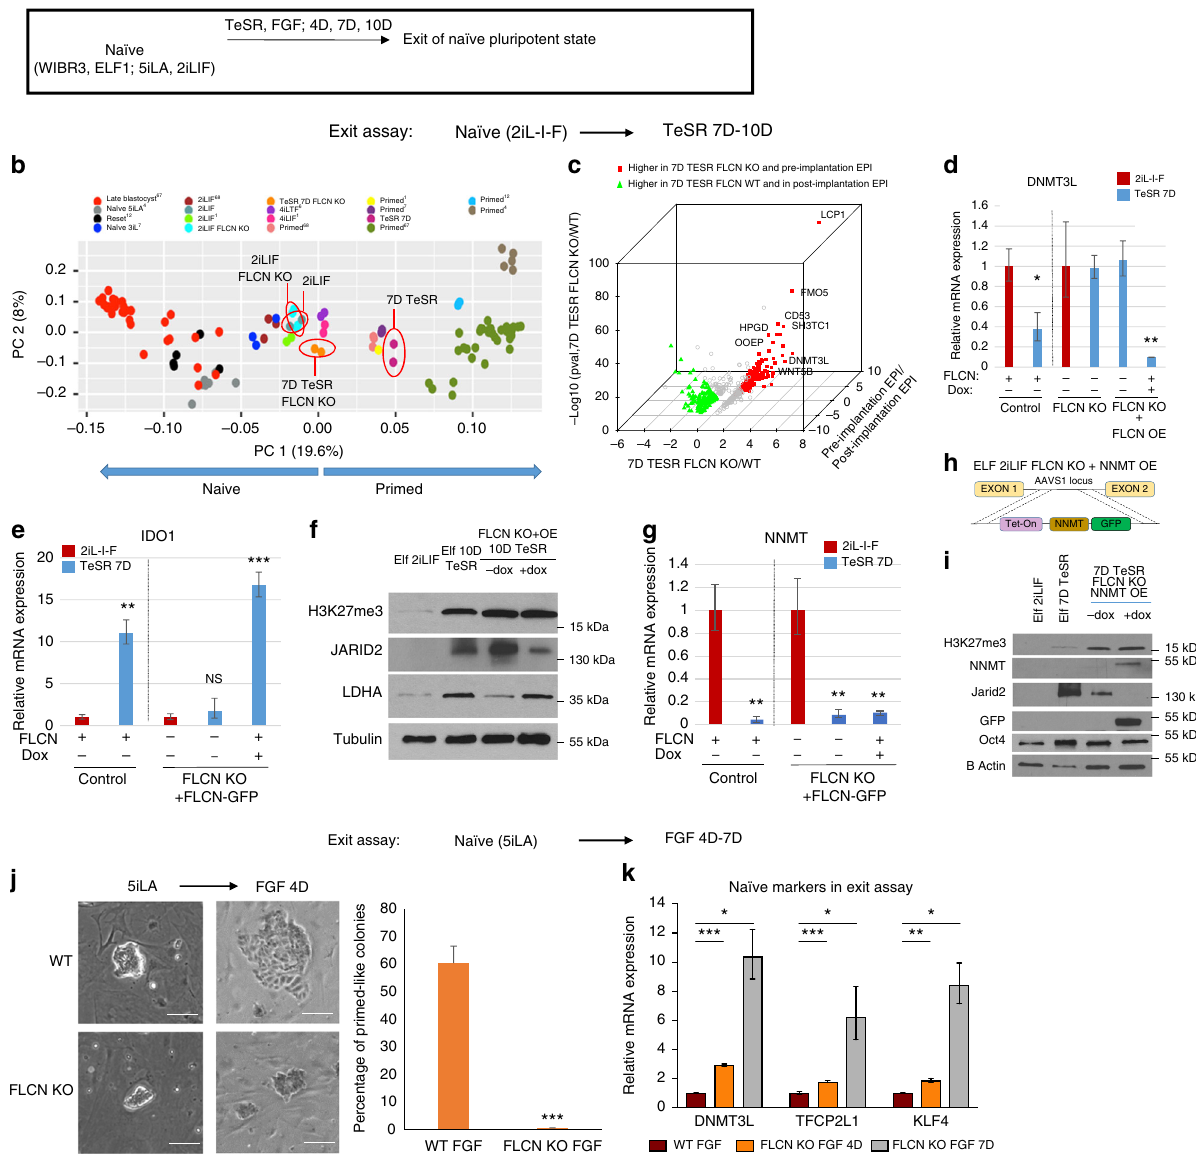
Fig. 3 FLCN is essential for the exit from the naïve pluripotency. a Schematic representation of experimental procedures used to exit naïve pluripotent state. b Principal component analysis after RNA-seq analysis reveals that FLCN KO hESC do not fully exit naïve state. RNA-seq from various pre-implantation in vivo human embryo 67 , naïve, and primed in vitro hESC were plotted, and separated in PC1 axis 1,6,7,11,12,67,68 . c Expression pattern of genes regulated by FLCN KO during exit of naïve state compared to cynomolgus monkey ( Macaca fascicularis 34 ) pre- vs. post-implantation stage. Red: genes up-regulated in 7D TeSR FLCN KO and pre-implantation; green: genes up-regulated in 7D TeSR WT and post-implantation. d , e RT-qPCR analysis of naïve (DNMT3L, d ) and primed (IDO1, e ) markers after exit of 2iL-I-F naïve state (7 day TeSR) in WT, FLCN KO, and rescue line (FLCN KO + OE FLCN-GFP). S.e.m.; * p < 0.05, ** p < 0.005, *** p < 0.001; two-tailed t -test, n = 3 – 6 biological replicates. Presented are the fold changes compared to naïve 2iL-I-F. f Western blot analysis of primed markers JARID2, LDHA, and H3K27me3 marks in naïve 2iL-I-F hESC and 10D TeSR hESC. g RT-qPCR analysis of NNMT expression. S.e. m.; ** p < 0.005; two-tailed t -test, n = 3 – 6 biological replicates. h Model of doxycycline inducible- NNMT-GFP fusion construct inserted into AAVS1 locus of 2iL-I-F FLCN KO hESC. i Western blot analysis of NNMT, GFP, H3K27me3, JARID2, and OCT4 after NNMT OE in FLCN KO 7D TeSR hESC. j , k FLCN KO cells retain naïve 5iLA morphology ( j ) and naïve markers DNMT3L, TFCP2L1, and KLF4 ( k ) when pushed to exit the naïve state (Exit assay: FGF 4 or 7 days; relative mRNA expression: fold changes of expression in FLCN KO vs. control (WT FGF: 4D or 6D, red bar). Complete data presented in Supplementary Fig. 3B. S.e.m.; * p < 0.05, ** p < 0.005, *** p < 0.001; two-tailed t -test, n = 3 – 6 biological replicates. Scale bars represent 100 μ m